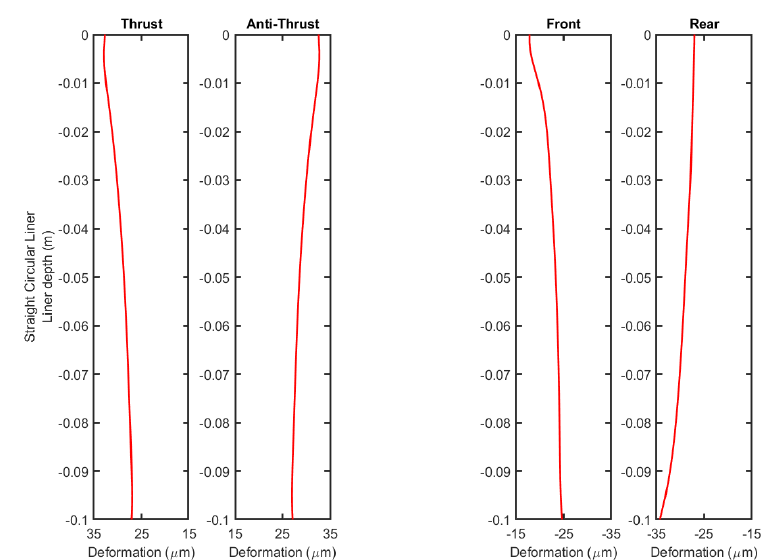
Figure 2. Simulation of the bore deformation for fired conditions for the originally straight circular liner for the four sides of the terminal cylinder.